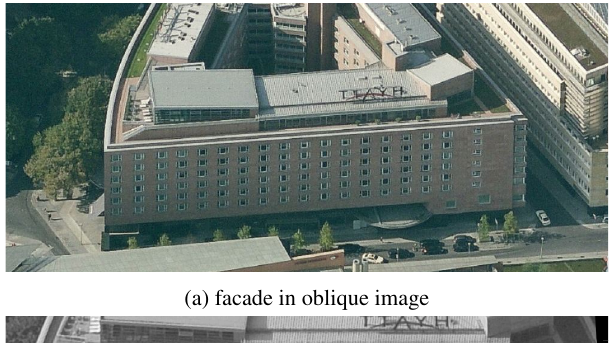
Figure 9. (a) shows the rectified building facade overlayed